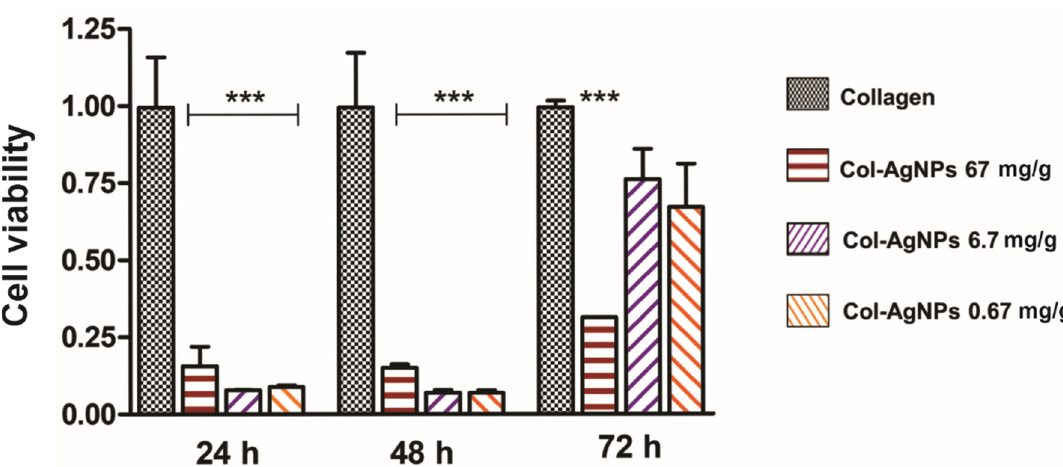
Figure 7. Viability of MDCK epithelial cells evaluated by the MTT test. Cell viability is plotted as a function of time for Col (black), Col-AgNPs 67 mg/g (red), Col-AgNPs 6.7 mg/g (violet) and Col-AgNPs 0.67 mg/g (orange). Viability rate in pure collagen hydrogels were considered as 1 at each time tested. Results are expressed as mean ± SD from triplicate experiments. ***Statistical significance (p < 0,001)